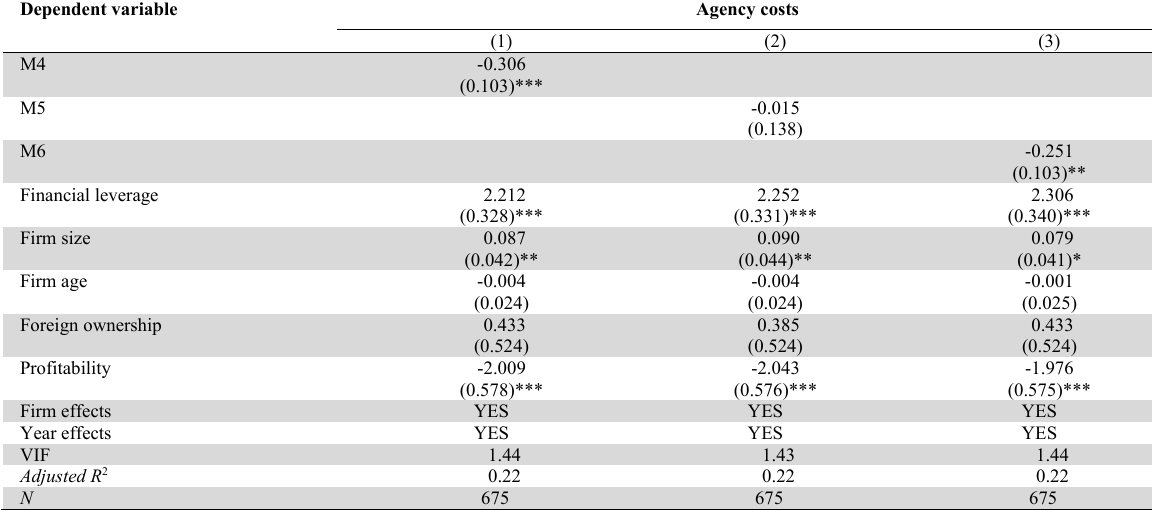
Minority investor protection mechanisms (extent of shareholder governance indicators) and agency